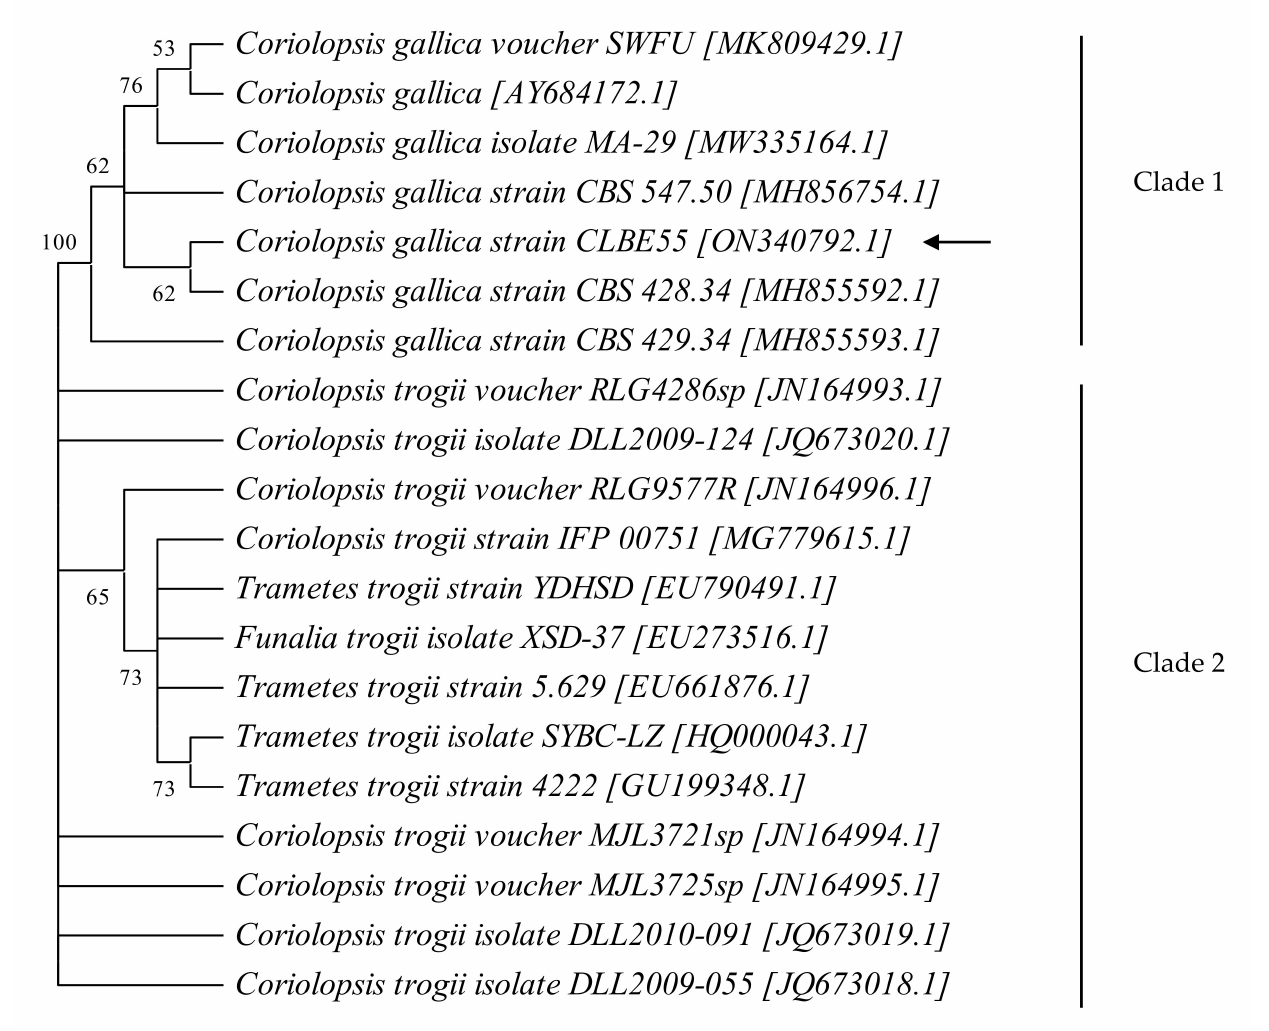
Figure 1. Bootstrap consensus tree of Coriolopsis gallica obtained by the maximum likelihood method. Bootstrap values at more than 50% from 1000 replications are shown in the branches. All strains are given with their accession number in brackets. C. gallica strain CBS 428.34 is flagged with an